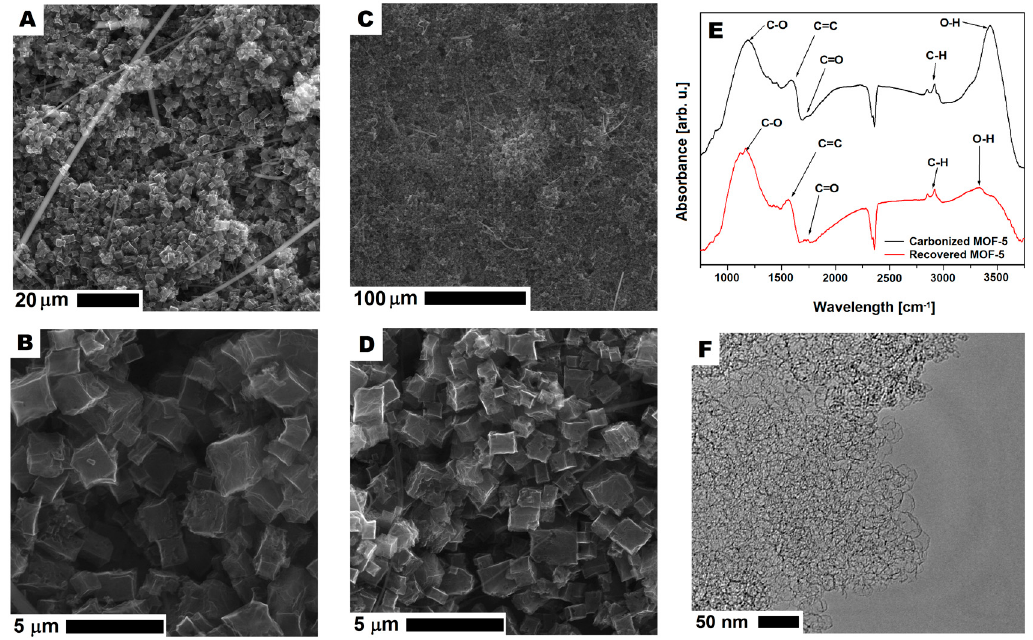
Figure 14. The SEM ( A – D ) and TEM ( F ) images of carbonized MOF-5 after recycling and purification. The FT-IR spectrum of carbonized MOF-5 before electrode preparation and after CMOF-5 recovery ( E ).